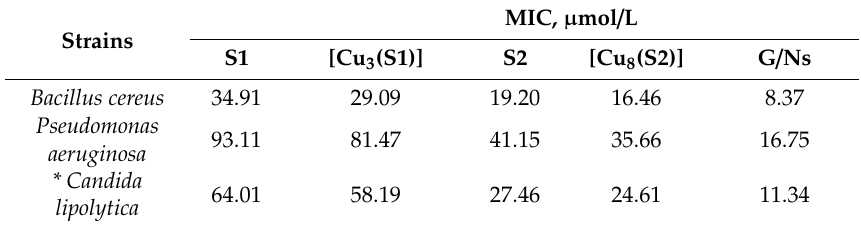
Table 3. MICs of S1 and S2 and of their Cu(II) complexes towards the tested model bacteria and yeasts.